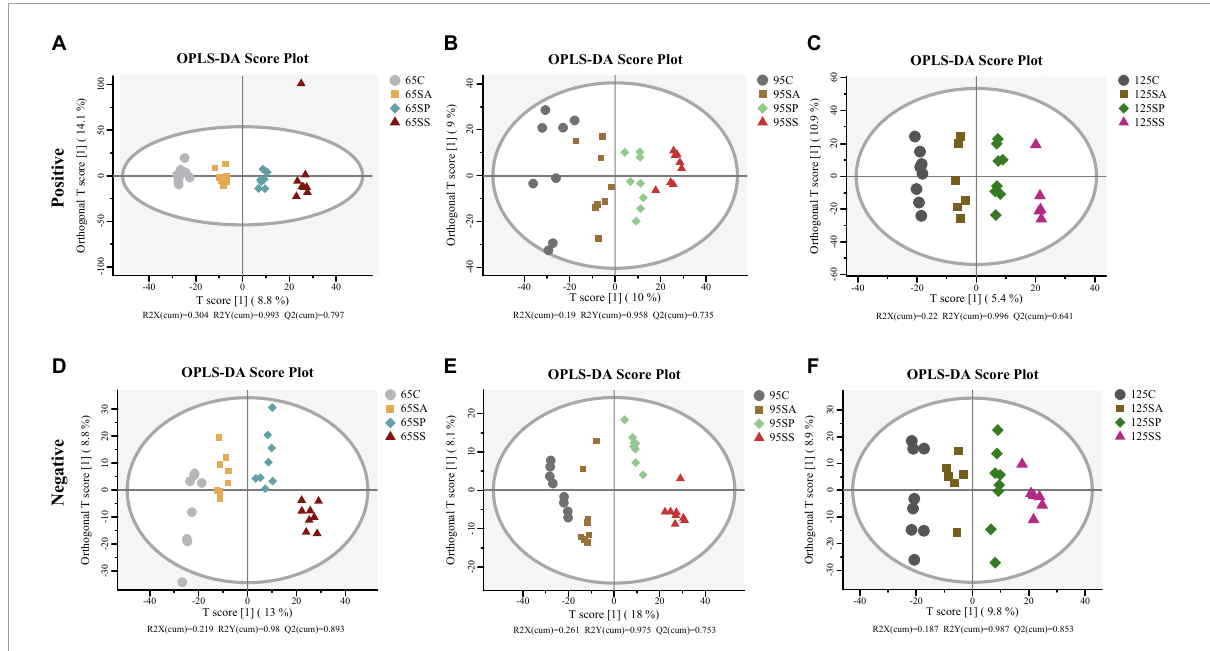
FIGURE5 Orthogonal partial least squares discriminant analysis (OPLS-DA) plots based on the metabolites in colonic contents of offspring pigs. The OPLS-DA plots of the metabolites in colonic contents in positive (A–C) and negative (D–F) modes at 65, 95, and 125 days of age among the four groups. 65C, 95C, and 125C, sow fed with basal diet; 65SA, 95SA, and 125SA, sow fed with antibiotic; 65SP, 95SP, and 125SP, sow fed with probiotics; 65SS, 95SS, and 125SS, sow fed with synbiotics.